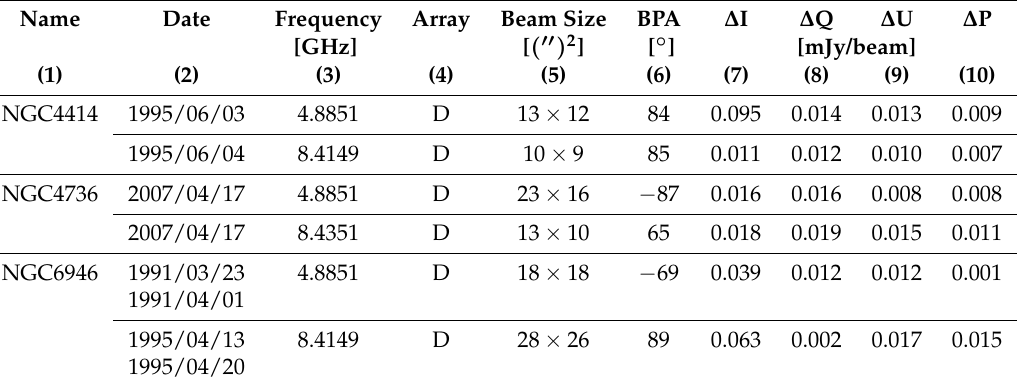
Table 2. Information of VLA archive data.